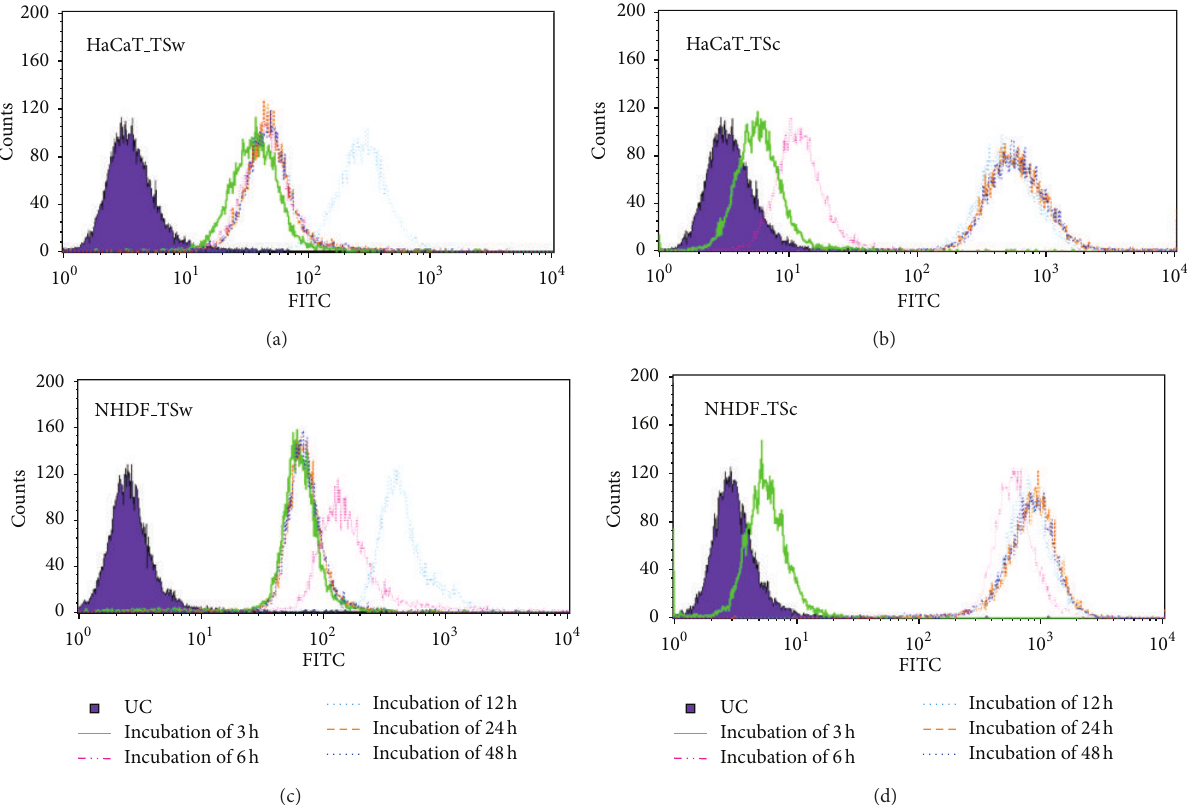
Figure 6: Fluorescence intensity of 50 𝜇 g/mL FITC-TSw ((a) and (c)) and FITC-TSc ((b) and (d)) in HaCaT and NHDF measured with flow cytometer after incubation for 3 h to 48h.